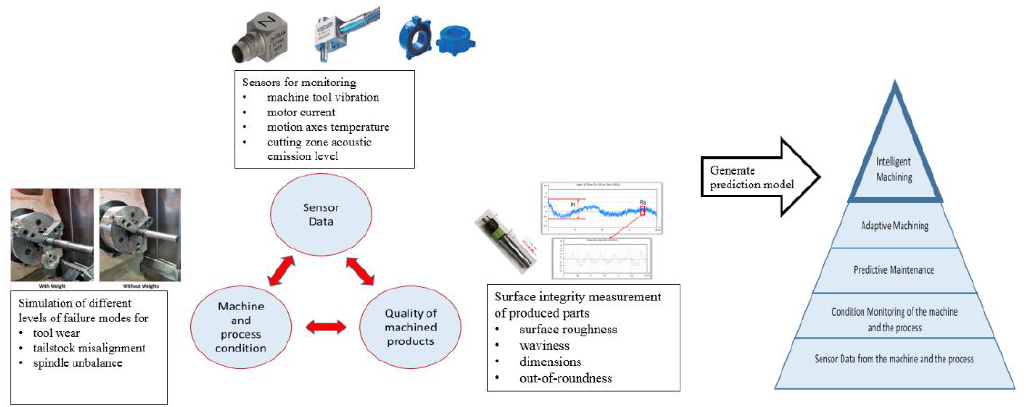
Figure 3. Correlation between machine and process condition, sensor data, and quality of machined